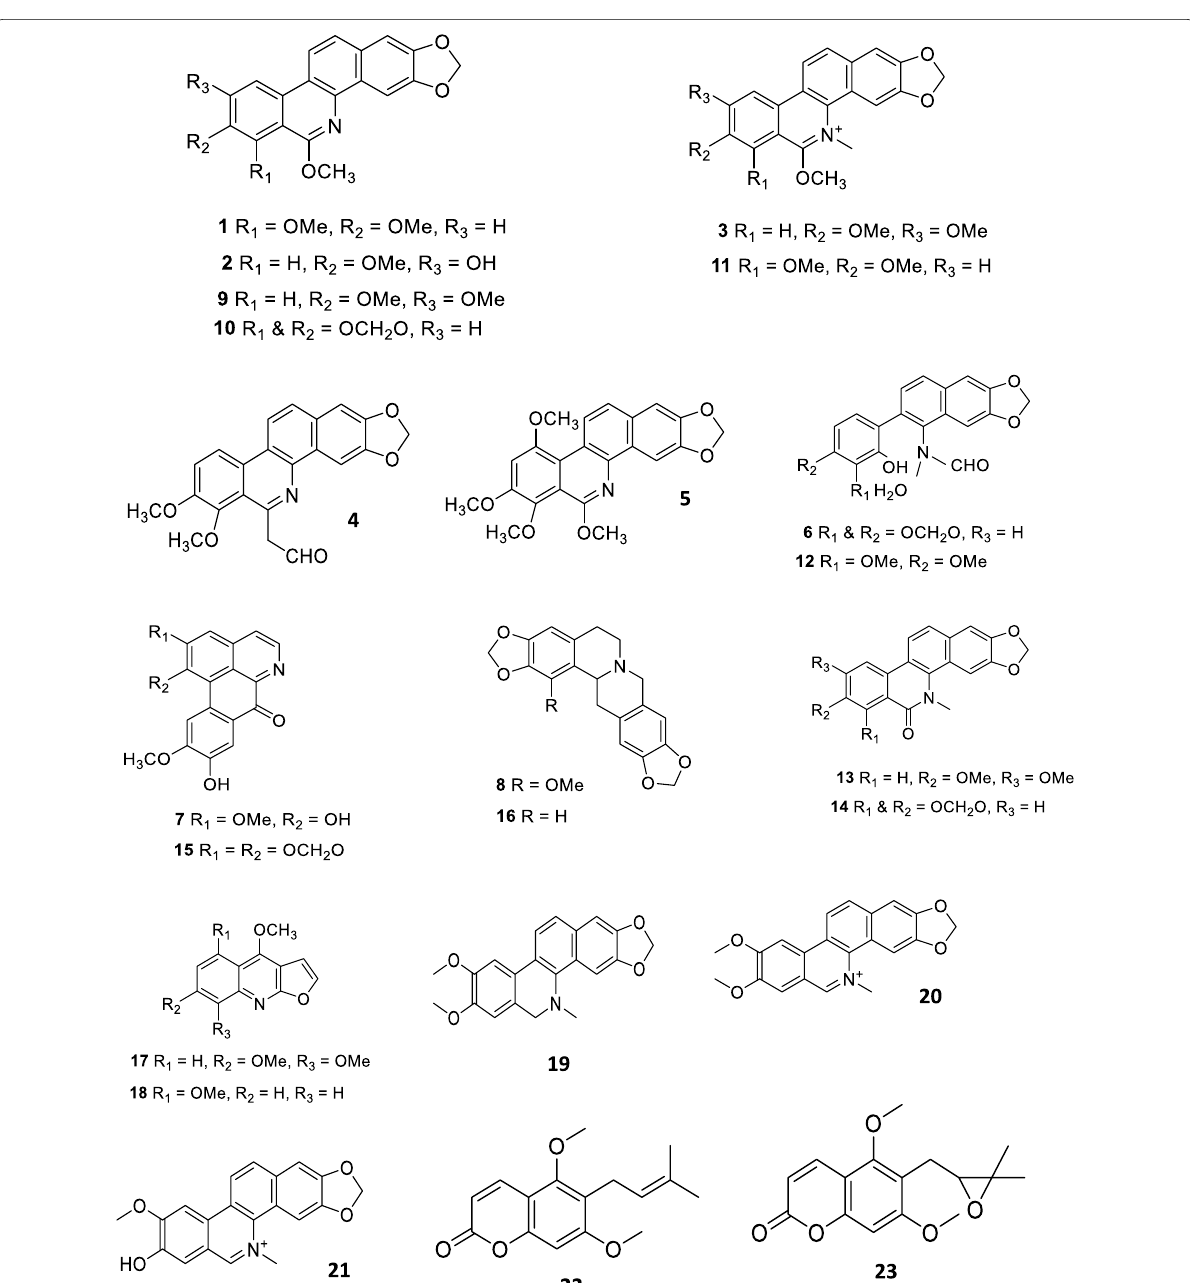
Fig. 4 Some of the anticancer molecules reported in anticancer plants used in Kenya. The compounds numbered 1–52 correspond to the molecules mentioned in Table